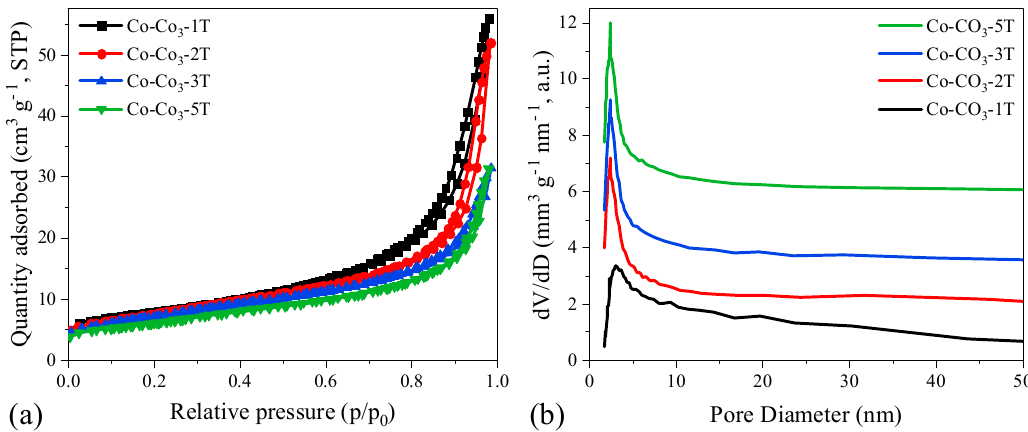
Figure 5. ( a ) N 2 -sorption isotherms and ( b ) pore size distribution curves of the catalysts.